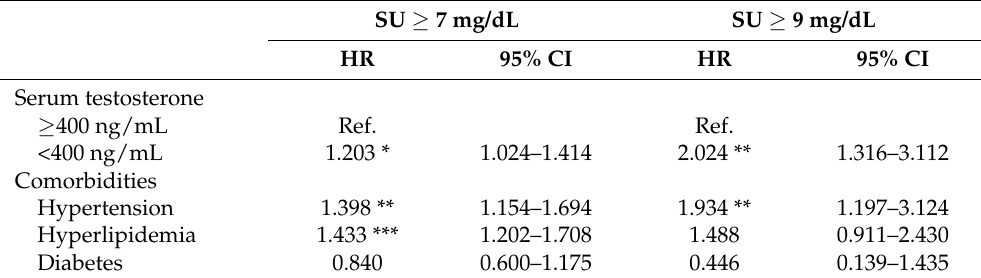
Table 2. Risk of developing hyperuricemia according to the serum testosterone level and presence of comorbidities.